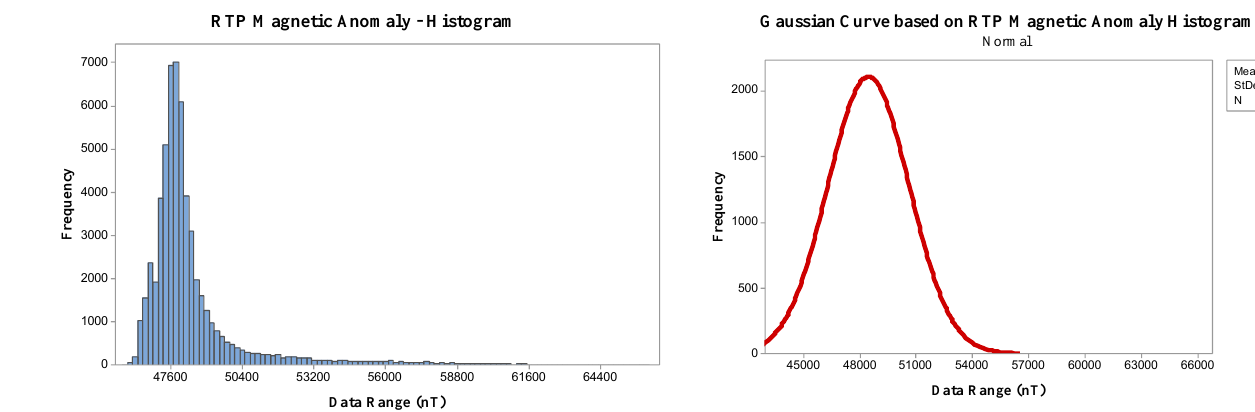
Figure 4. Histogram of RTP-MA data in Qoja-Kandi.